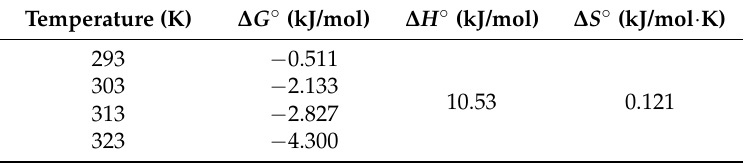
Table 4. Isotherm constants and correlation coefficients for the biosorption of Cr(VI).